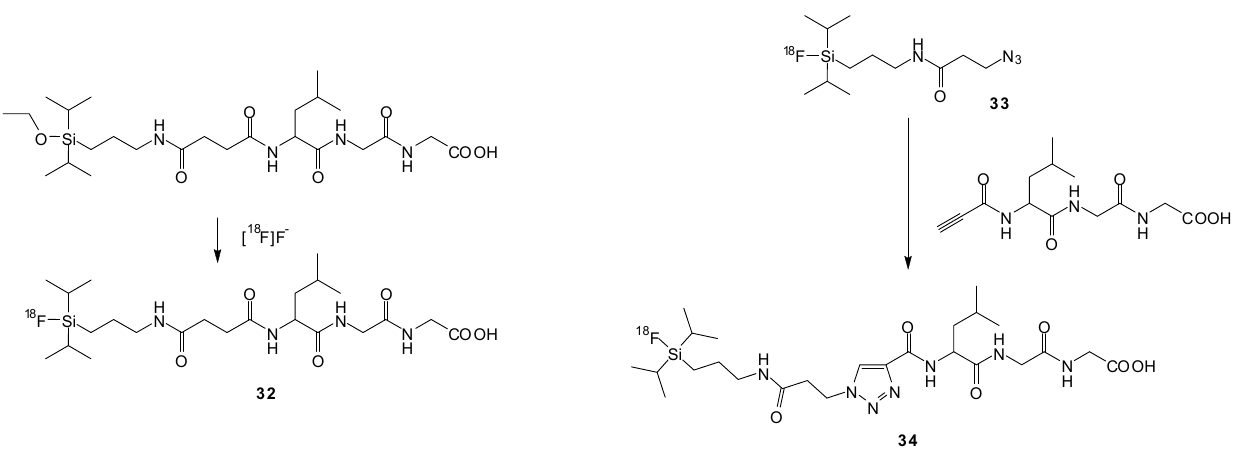
Figure 10. Course of labeling reactions described by Balentova et al .